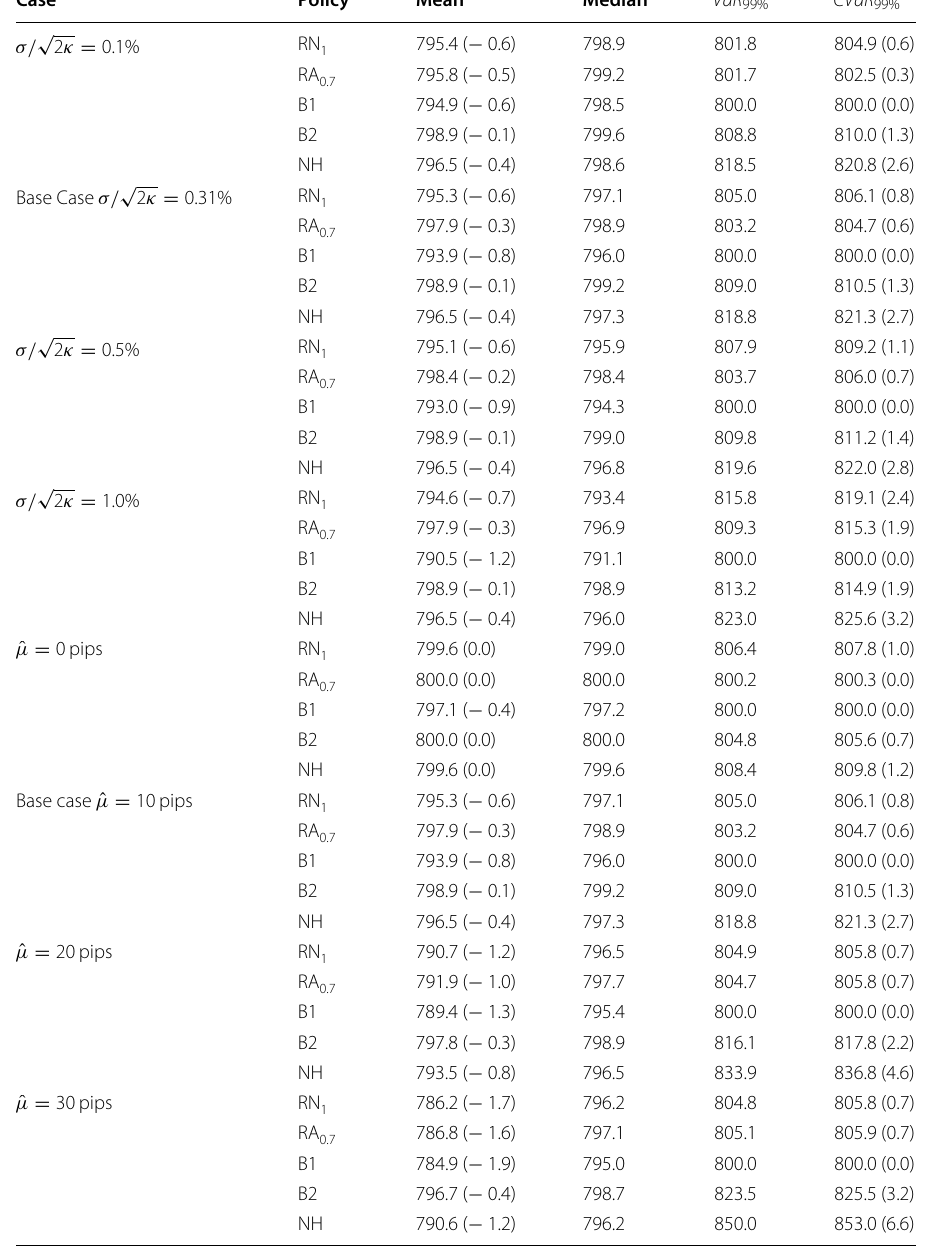
Table 9 (Up): Sensitivity analysis of the long‑term volatility σ/ √ 2 κ in the mean reverting intraday price process for